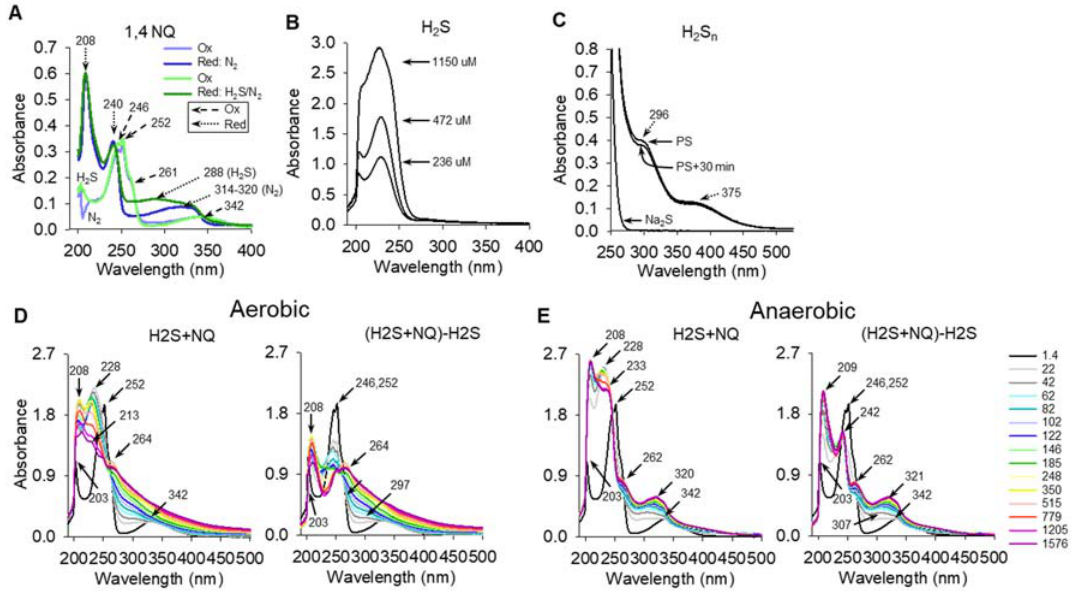
Figure 6. ( A ) Absorbance spectra of oxidized 1,4-NQ (60 µ M, light blue/green lines) and after reduction with either N 2 gas (dark blue line) or 1 mM H 2 S, followed by N 2 gas to remove excess H 2 S (dark green line). ( B ) Spectra of different concentrations of H 2 S (as Na 2 S); ( C ) spectra of mixed polysulfides (H 2 S n ) produced by anaerobic incubation of Na 2 S with powdered sulfur (S 8 ) in 200 mM phosphate buffer (pH 7.4). Numbers indicate approximate wavelength of peaks. ( D , E ) Absorbance spectra as a function of time of the reaction between 230 µ M 1,4-NQ and 115 µ M H 2 S in aerobic (21% O 2 ) and anaerobic (<1% O 2 ) buffer. Left panels (H 2 S + NQ) of each pair show the full spectra, in the right panels (H 2 S + NQ) − H 2 S) the H 2 S spectrum was subtracted from the H 2 S + NQ spectrum at each time point. The time, in seconds, after addition of H 2 S is indicated on the right of panel ( E ). Time ‐ resolved spectra of the addition of 115 μ M of H 2 S to 230 μ M 1.4 NQ (1:2 H 2 S:1,4 ‐ NQ) in aerobic (21% O 2 ) or anaerobic (<1% O 2 ) buffer are shown in the left panels in Figure